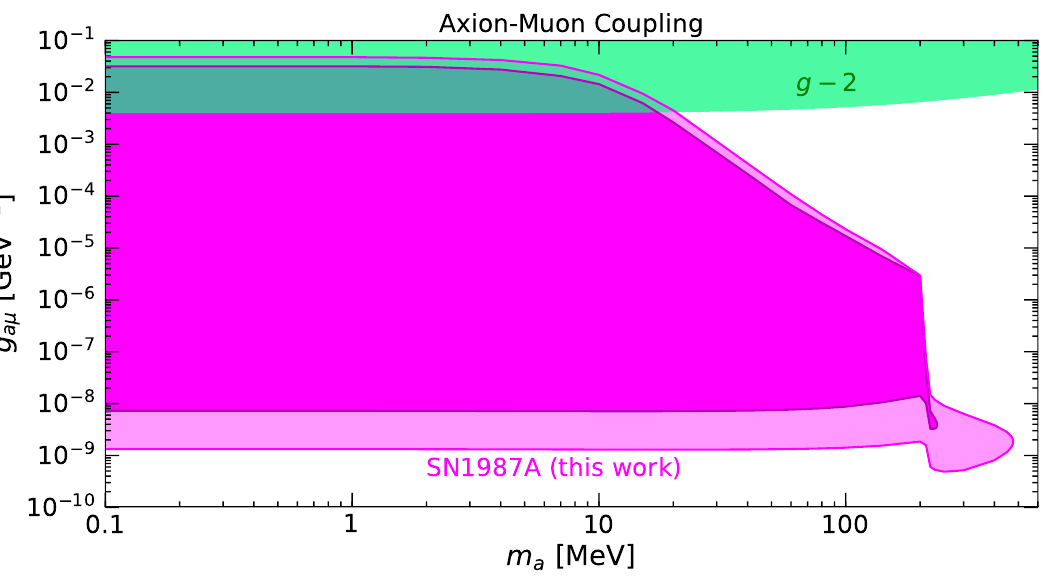
Figure 8. Axion-muon coupling parameter space. Our new SN1987A limit is shown as the magenta shaded region. Inner region is conservative calculation, outer is less conservative (see